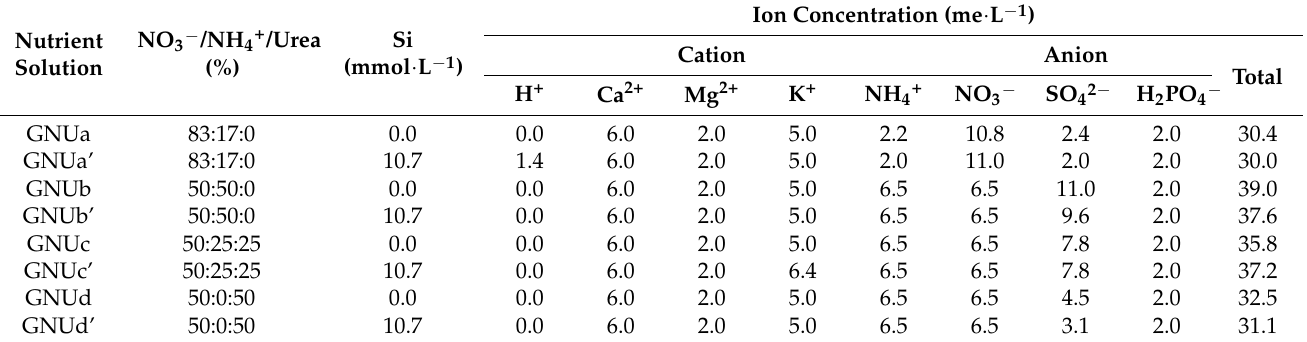
Table 5. Concentrations of macro-element cations and anions used in nutrient solutions in experiment